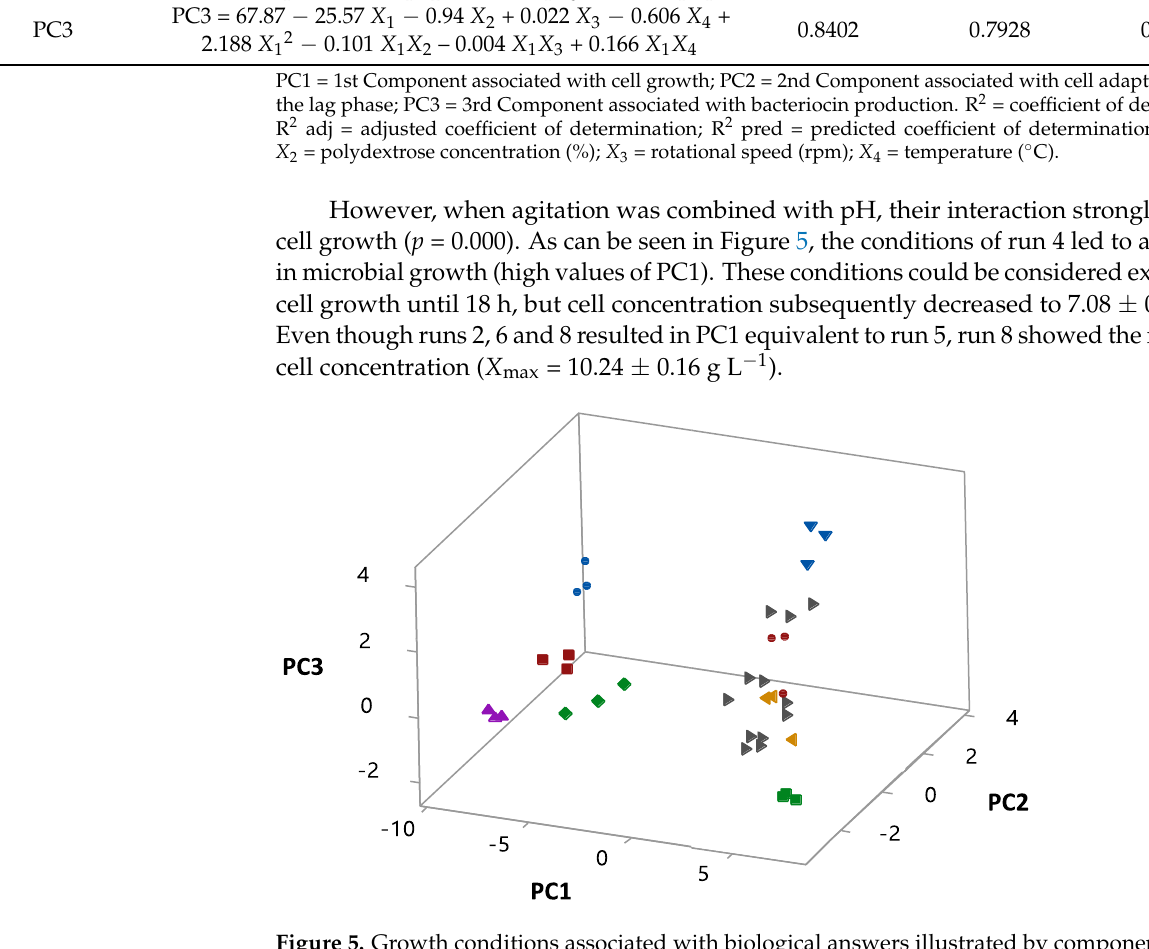
PC1 = 1st Component associated with cell growth; PC2 = 2nd Component associated with cell ad- aptation during the lag phase; PC3 = 3rd Component associated with bacteriocin production. R 2 = coefficient of determination; R 2 adj = adjusted coefficient of determination; R 2 pred = predicted coefficient of determination. X 1 = pH; X 2 = polydextrose concentration (%); X 3 = rotational speed (rpm); X 4 = temperature (°C).